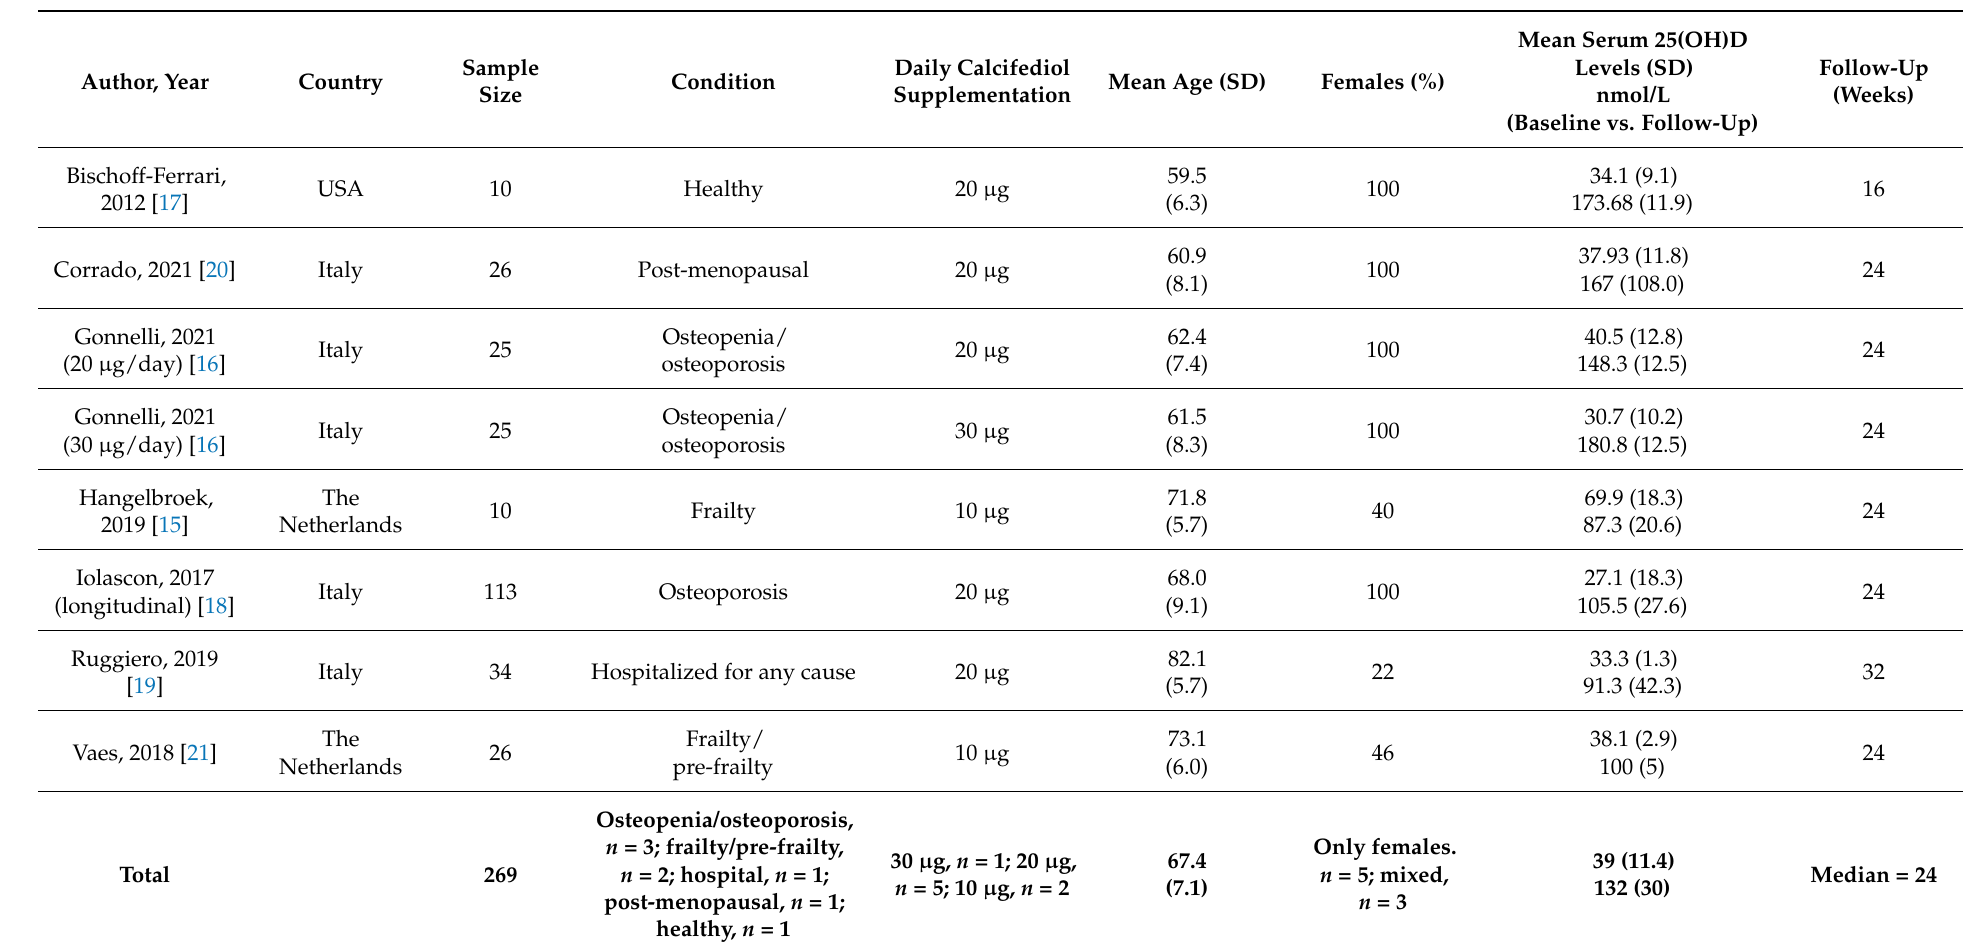
Table 1. Descriptive findings of the studies